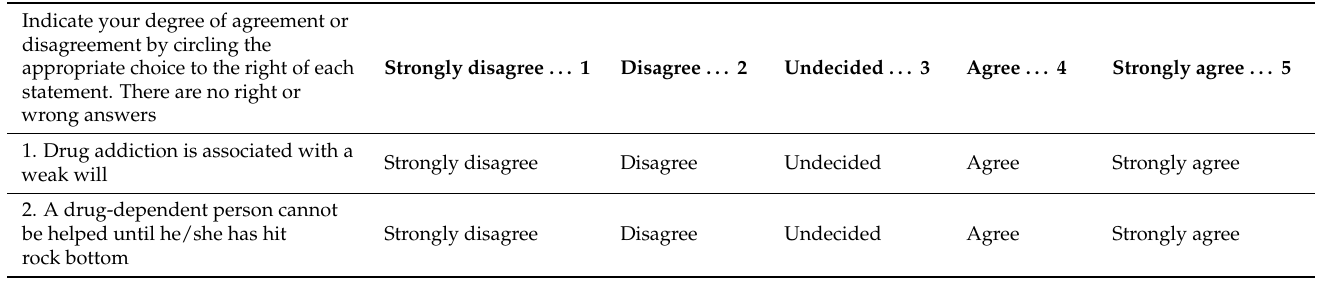
Table A1. Questionnaire bSAAS (29 Items) and Sociodemographic